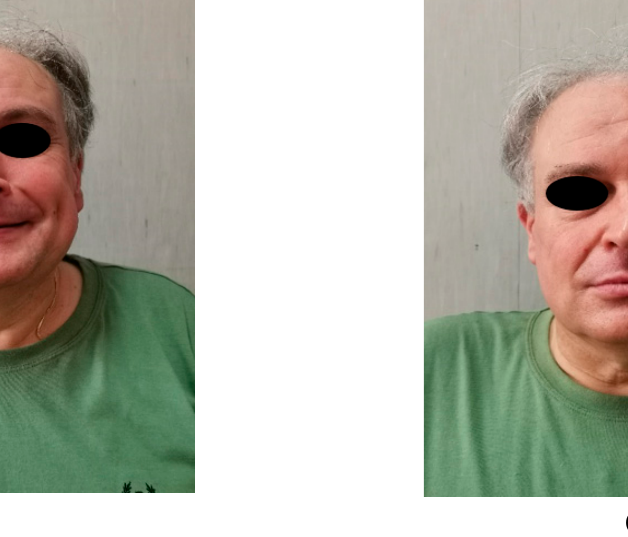
Figure 3. ( a ) Intraoperative photos of the surgical excision. ( b ) The anatomopathological specimen. At the 6-month follow-up, after Kabat therapy, the patient recovered a facial nerve deficit of about 85% and did not show signs of recurrency (Figure 4a,b).